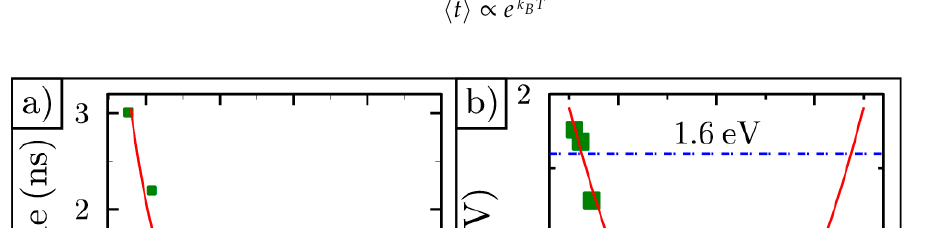
Figure 5. Potential energy and ripple shape: ( a ) Double-well potential for strain of − 0.7%; ( b ) Illus- tration of a possible ripple shape during inversion, along with its cross-section. 3.3. C. Physical Transformation during Ripple Inversion To study the shape transformations, we first identified all the inversion events in a particular ripple simulation by plotting the central height over time, as shown in Figure 6a. Root-mean-square deviation (RMSD) analysis confirms the atom positions have stabi- lized within the first 0.2 ns. The initial time data are not included in the plot. After stabi- lizing, the ripple’s height is positive in the beginning, then flips 6 times during the next 8 ns. To track the larger structure of the ripple, we also recorded the height of the ripple along both the x-axis and y-axis every picosecond. From these datasets, we determined